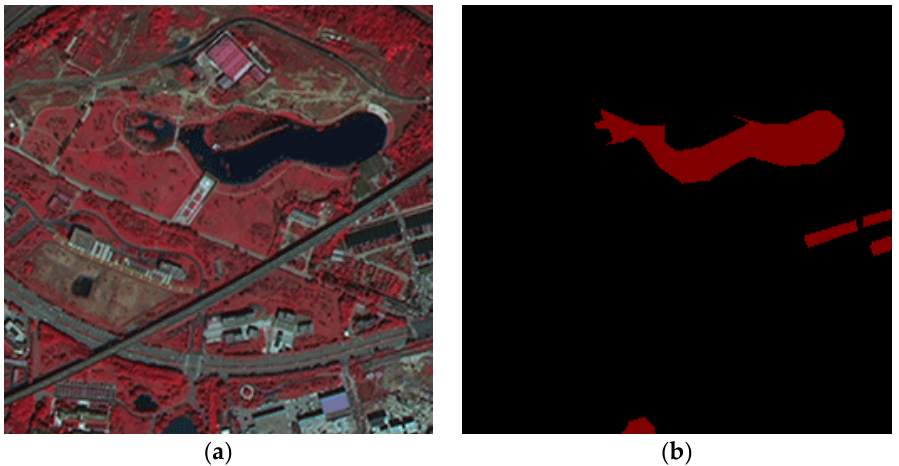
Figure 7. Remote sensing image and regional waterbody labeled image. ( a ) Remote sensing image; ( b ) regional waterbody labeled image.